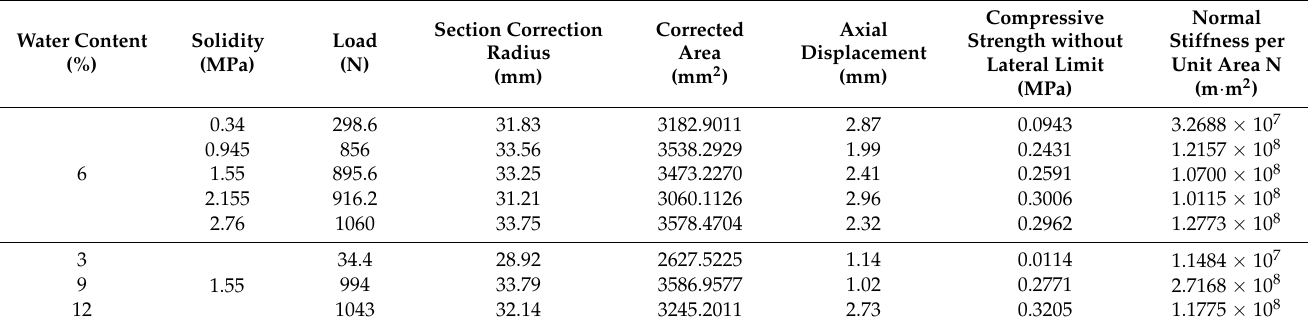
Table 3. Results of unconfined compressive tests on soil with different moisture content and firmness.